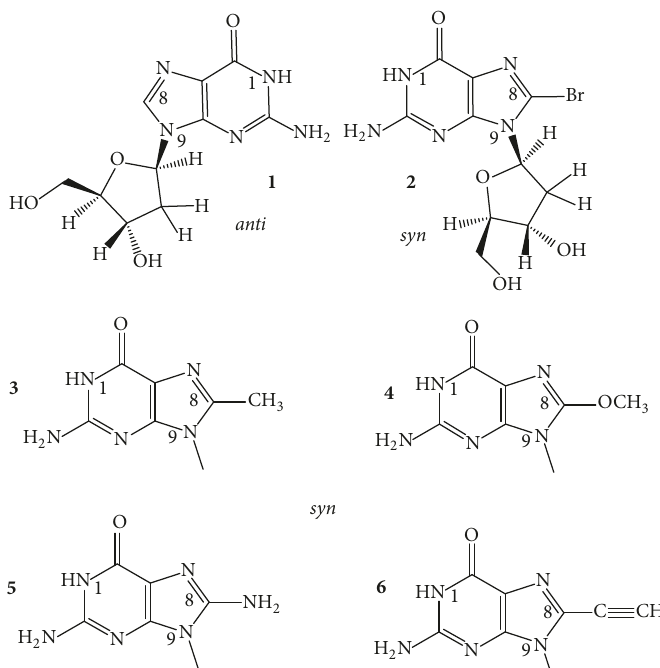
Figure 6: Structures of anti 2 󸀠 -deoxyguanosine ( 1 ); syn 8-bromo-dG ( 2 ); 8-methylguanine ( 3 ); 8-O-methylguanine ( 4 ); 8-aminoguanine ( 5 ); 8-propynylguanine ( 6